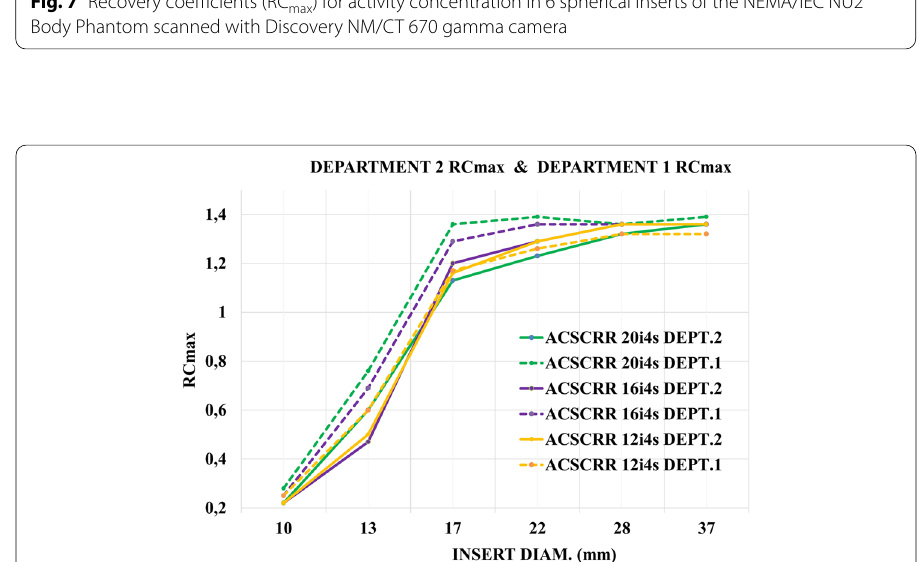
Fig. 8 RC max values as a function of the sphere diameter of the NEMA/IEC NU2 Body Phantom, for two gamma cameras in two departments. The dashed lines represent the results obtained by the gamma camera Discovery NM/CT 670 in Department 1; the continuous lines represent the results obtained by the gamma camera NM/CT 850 in Department